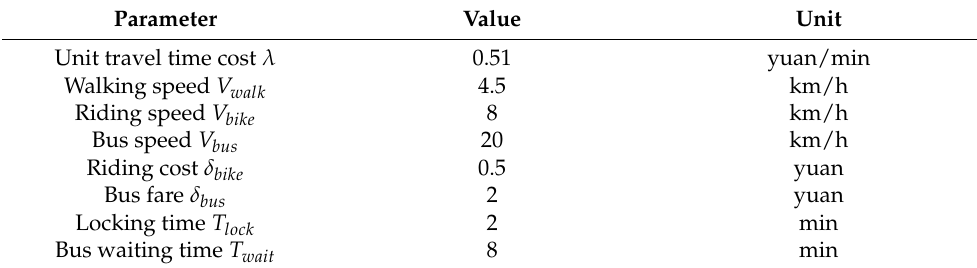
Table 2. The Values of Model Parameters.